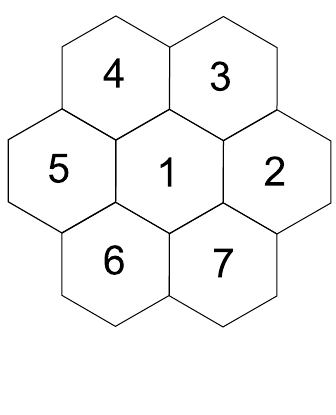
Figure 9 . One tile consisting of 7 hexagons.